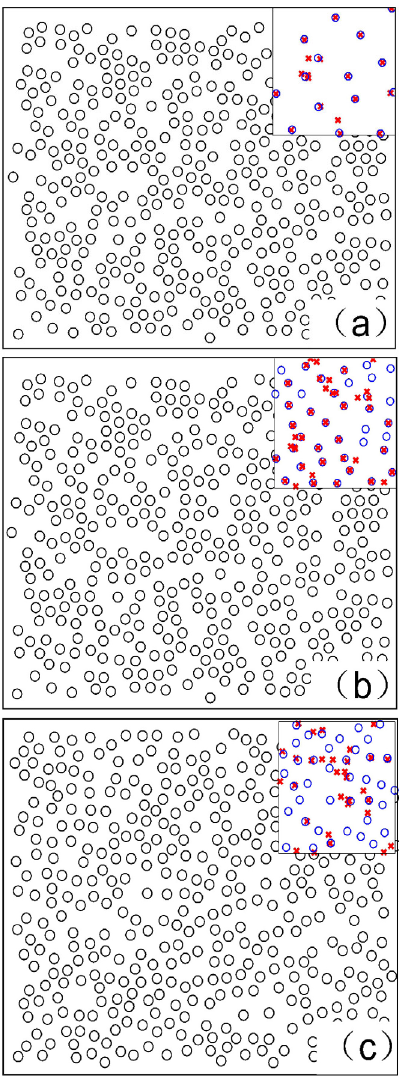
Fig. 8 Coordinates of colloidal particles at different tem- peratures corresponding to (a) = 0.001 T T , (b) = T T , and m0 m0 (c) = 1000 T T . The insets of (a), (b), and (c) show the snapshots m0 of (a), (b), and (c), respectively, with the substrate pinning centers denoted by